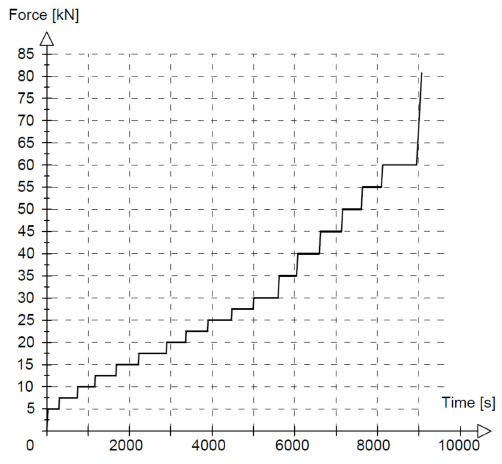
Figure 18. Loading with measurement